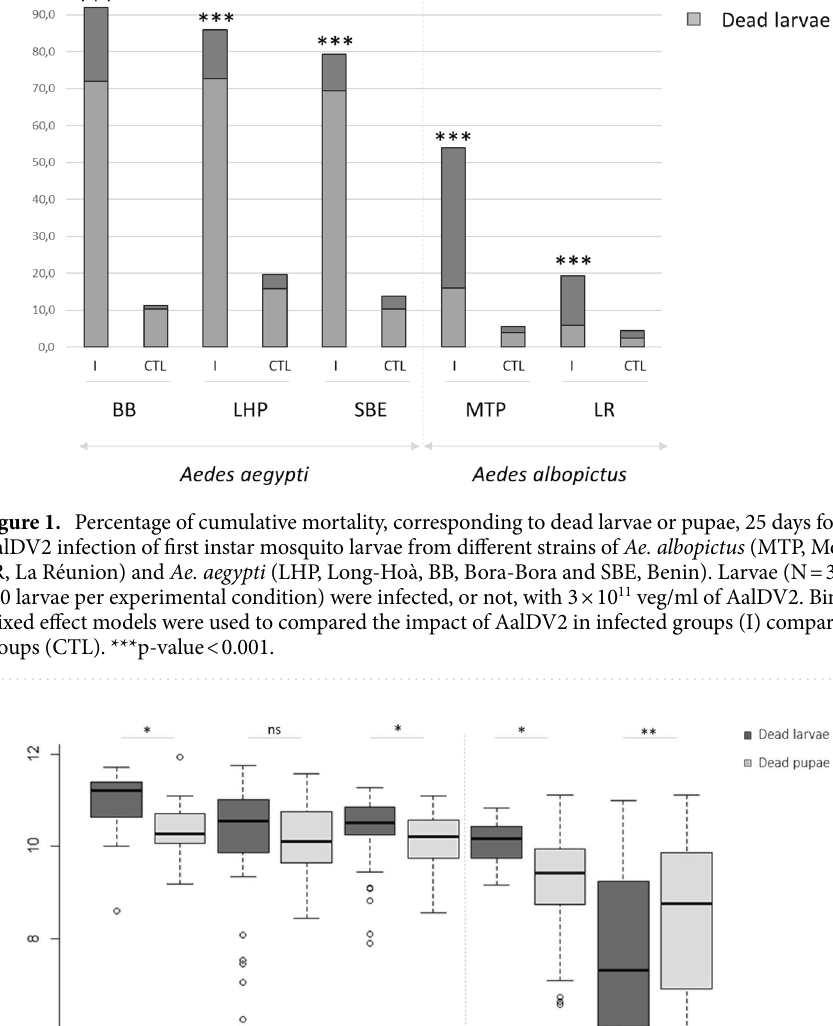
16% for the MTP and 6% for the LR strains of Ae. albopictus. Pupal mortality in Ae. albopictus was 38% for the MTP and 13% for the LR strains; compared to 13% for the LHP, 10% for the SBE and 20% for the BB strains of Ae. aegypti . Overall, there were significant differences in the pathogenicity of AalDV2 between the different strains of Aedes mosquitoes. Mortality was lower and occurred later for the tested strains of Ae. albopictus than for the Ae. aegypti strains. Dead mosquitoes were collected daily and analysed by qPCR for detection and quantification. In the infected groups, the virus was detected in all dead mosquitoes both in the larval and pupal stages (100%, N = 1322). Con- trol mosquito were negative for any densoviruses infection. Moreover, no virus detection was observed in the control mosquito samples that died during the experiment (N = 234). Figure 2 shows the viral dose quantified in dead larvae and pupae for each strain tested of Ae. albopictus and Ae. aegypti . Viral doses were slightly higher in